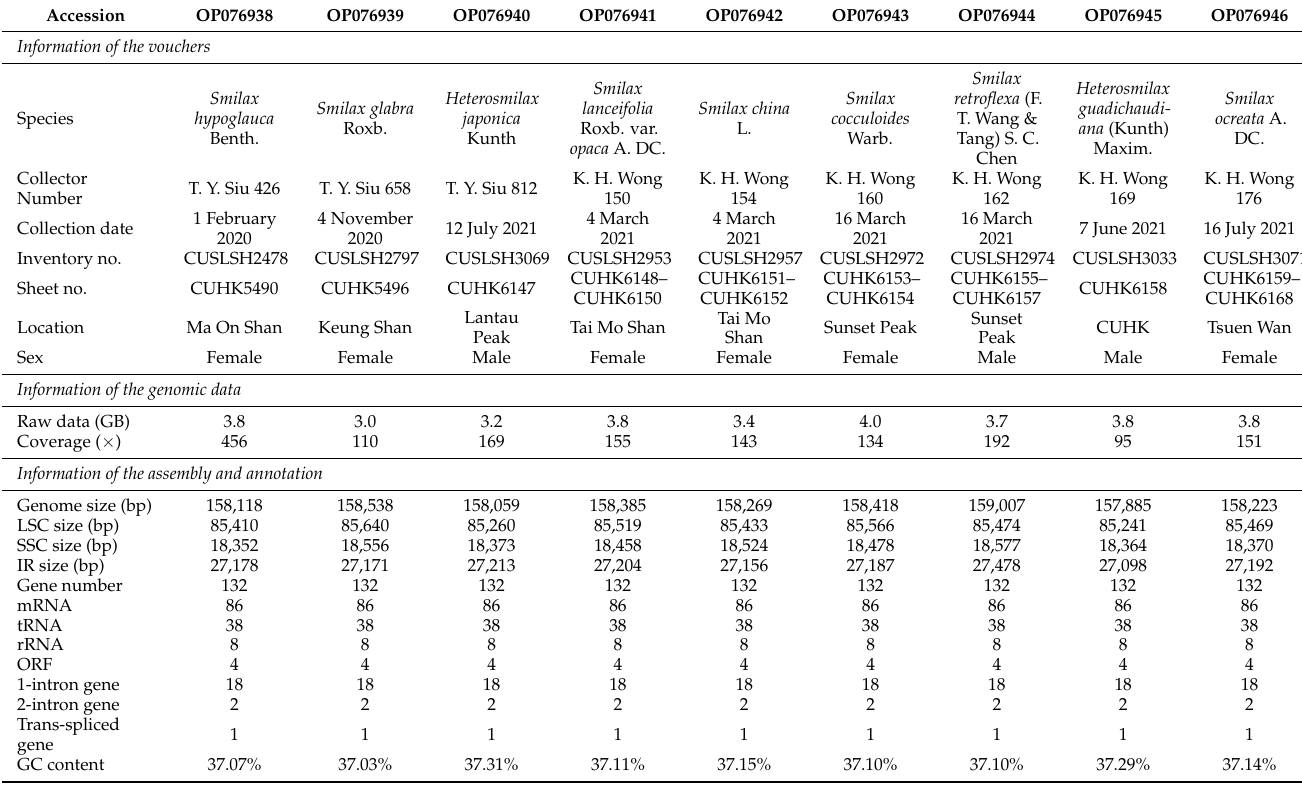
Table 1. Information of the nine newly assembled and annotated chloroplast genomes.